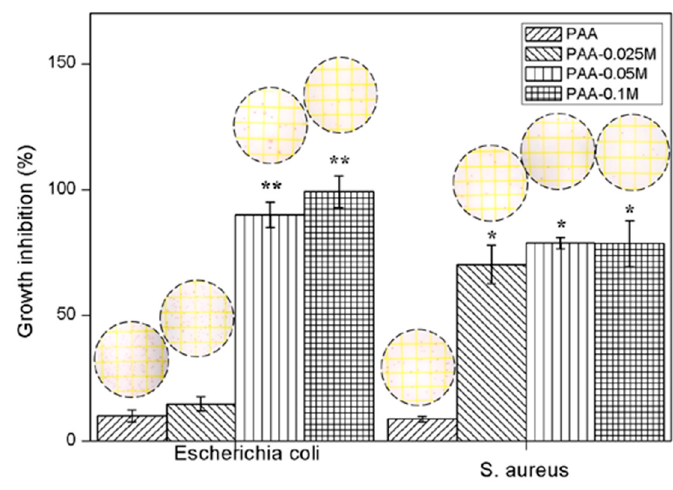
Figure 7. The inhibition rate of Zn–PAA and PAA against E. coli and S. aureus after 24 h of cultivation. (* p < 0.05 compared to PAA, ** p < 0.05 compared to PAA–0.025M and PAA).